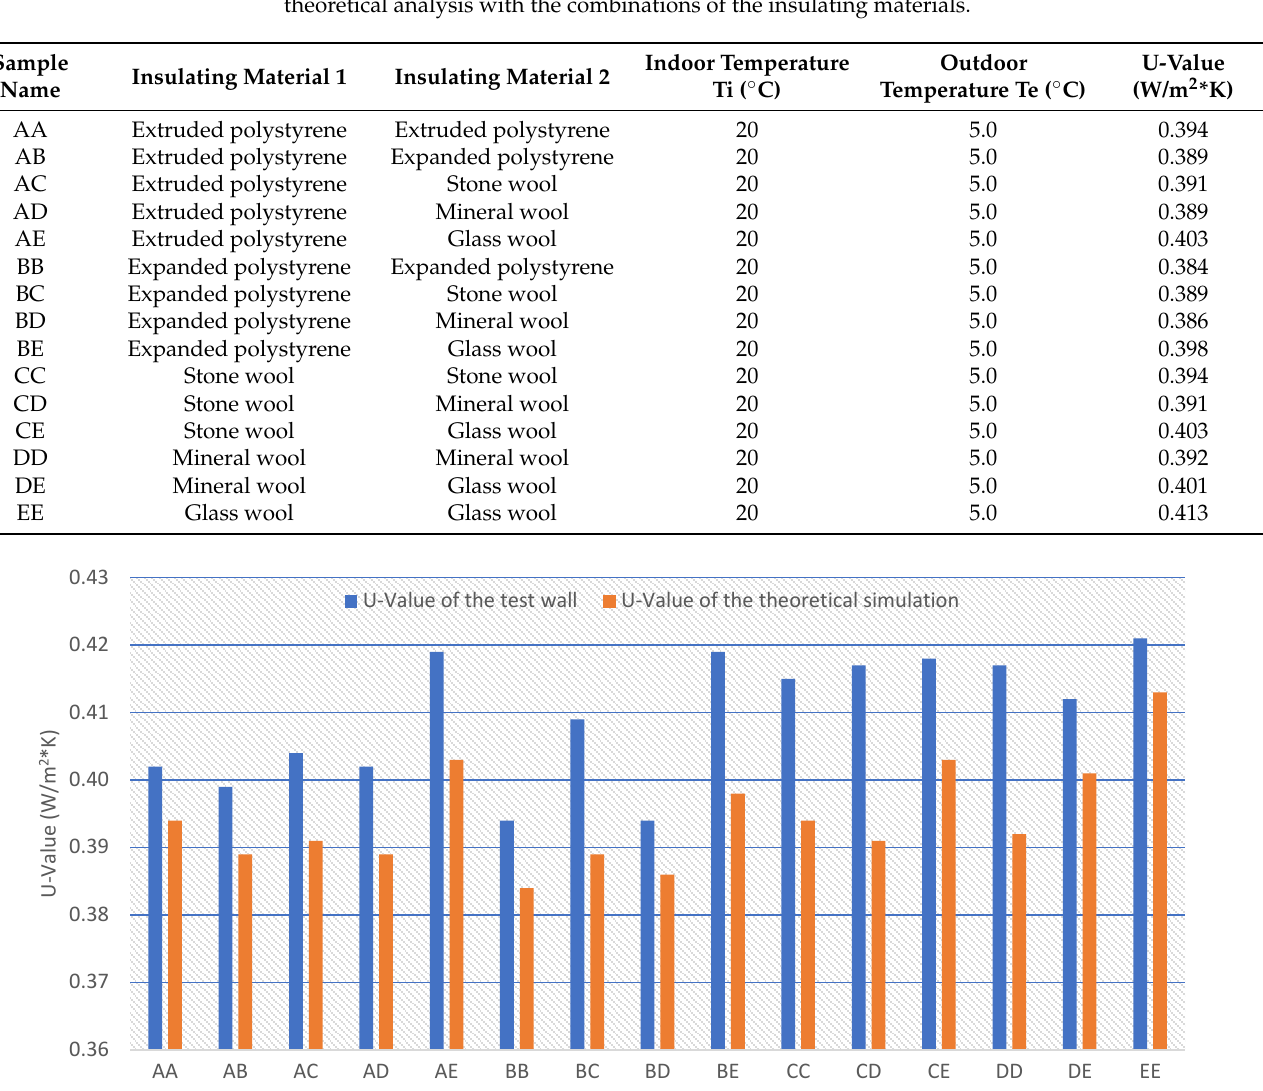
Figure 7. Comparative graphic representation of the U-Values. Laboratory measurements, blue bars; simulation software, red bars .